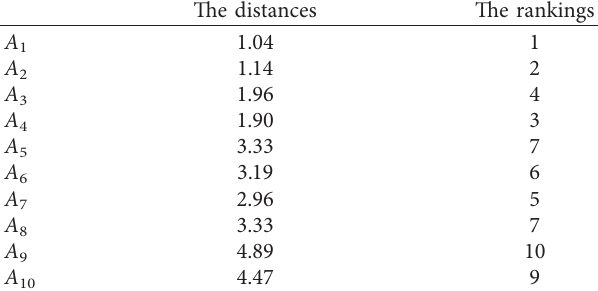
Table 10: The distances between the alternative judgment debtors and the ideal concealed judgment debtor and their corresponding